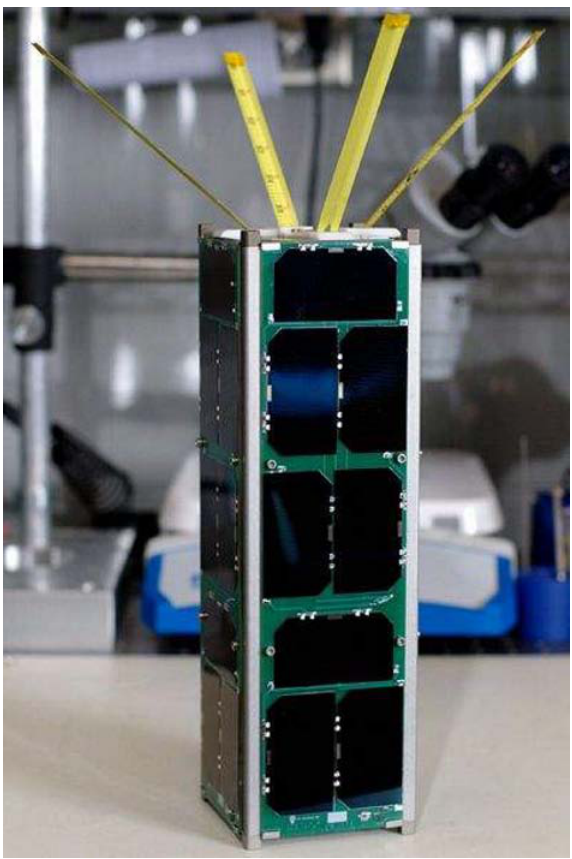
Figure 5. The completely integrated and assembled RAX Cube- Sat [20].